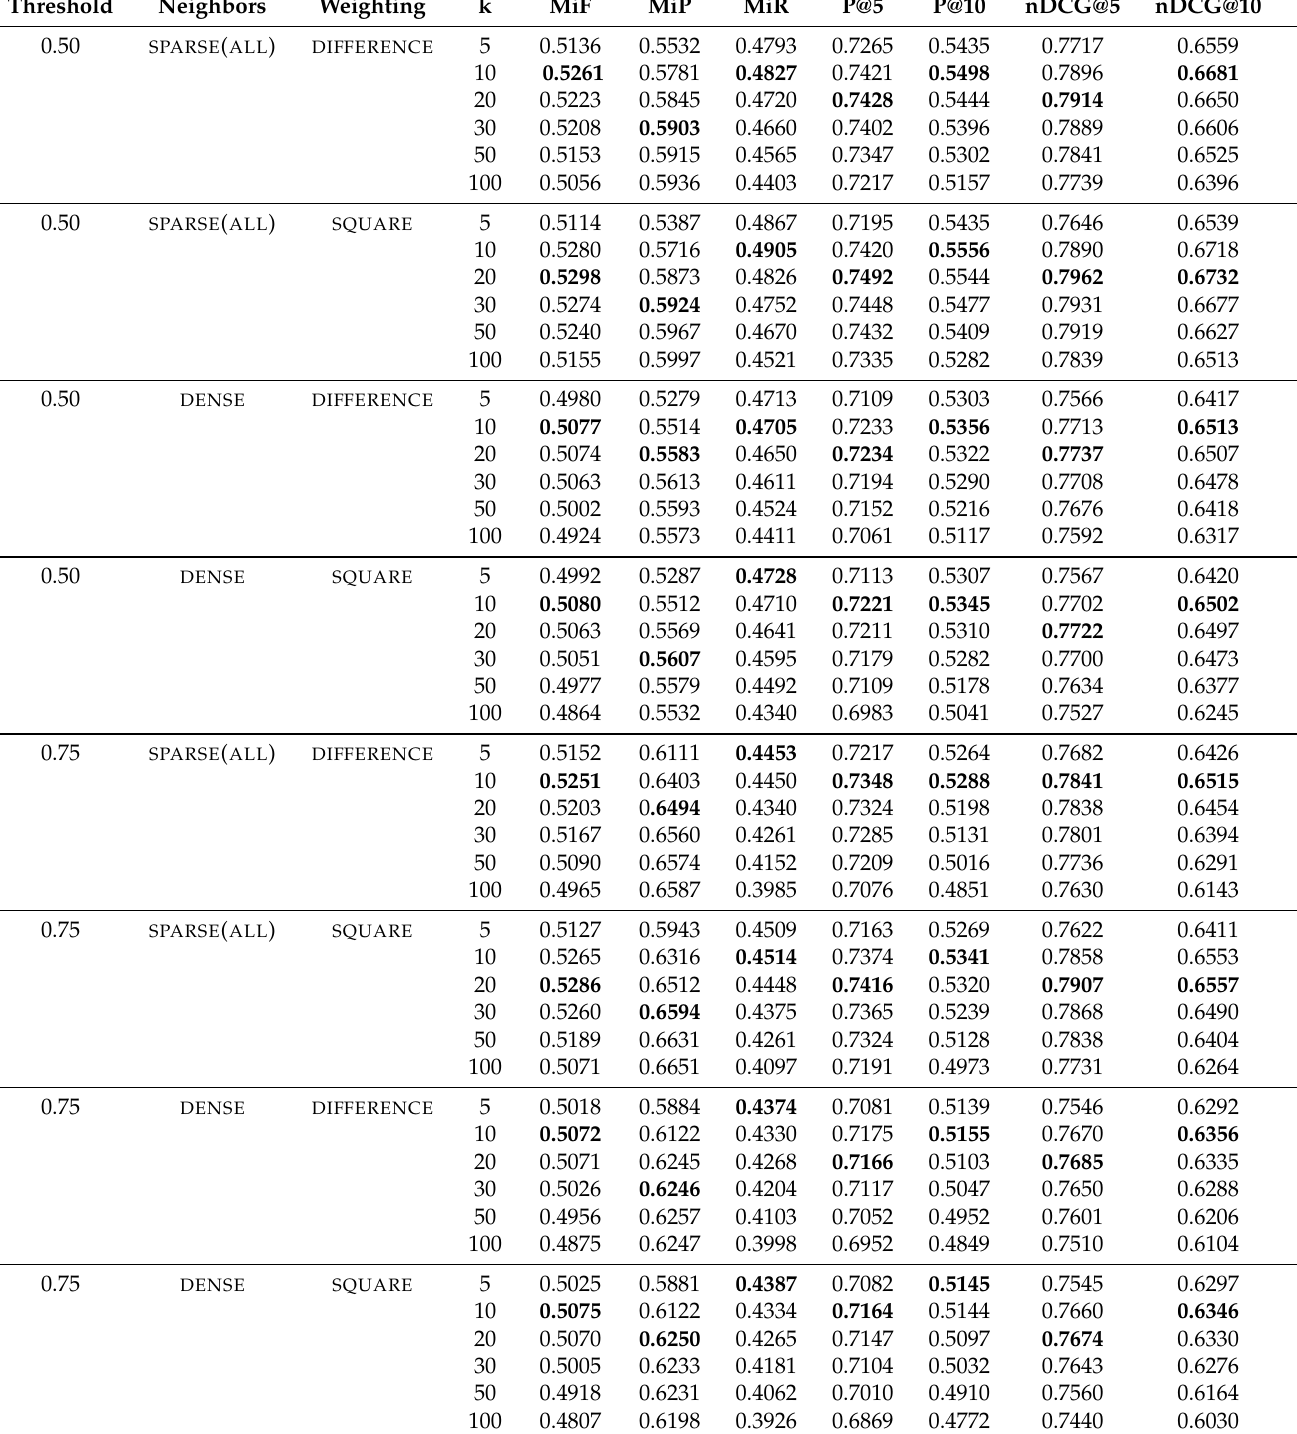
Table 6. Performance with MEDIUM label-AE